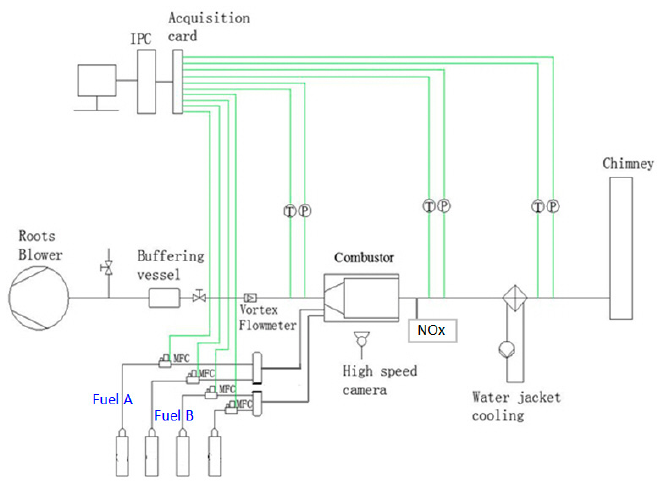
Figure 5. Layout of experimental setup.